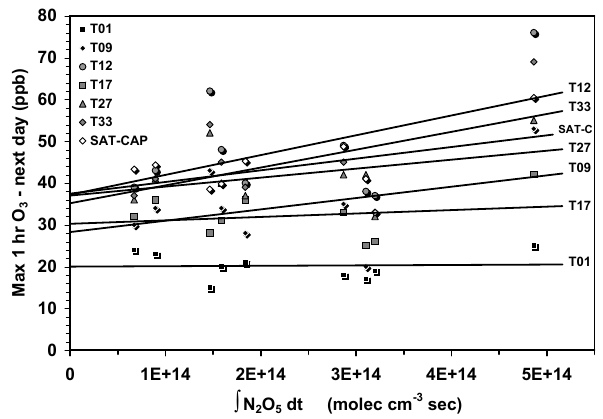
Fig. 10. Correlation of integrated N 2 O 5 concentration with respect to time over the course of the night and maximum 1 h average ozone the next day seen at monitoring stations in the Lower Fraser Valley. The analysis includes only nights in which a significant observable sea breeze was observed the next day have been